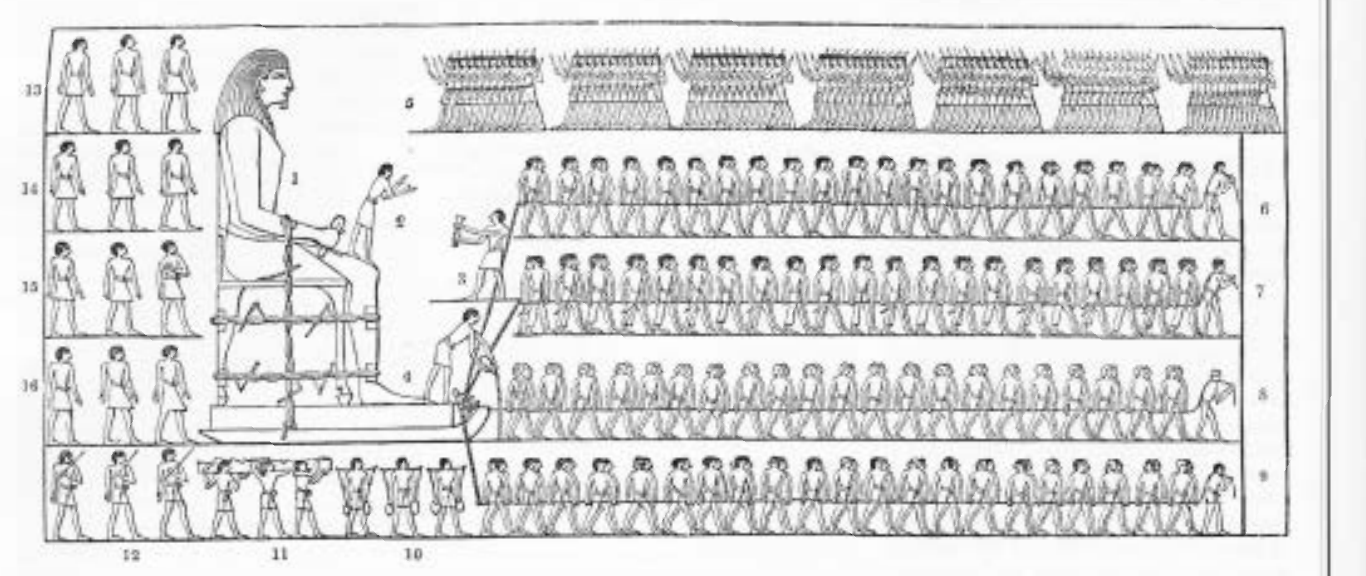
Figure 4 Djehutihotpe's statue being transported from the Hatnub travertine quarries, as depicted in his (Twelfth Dynasty) tomb at Deir el-Bersha (from Newberry 1895, seen.